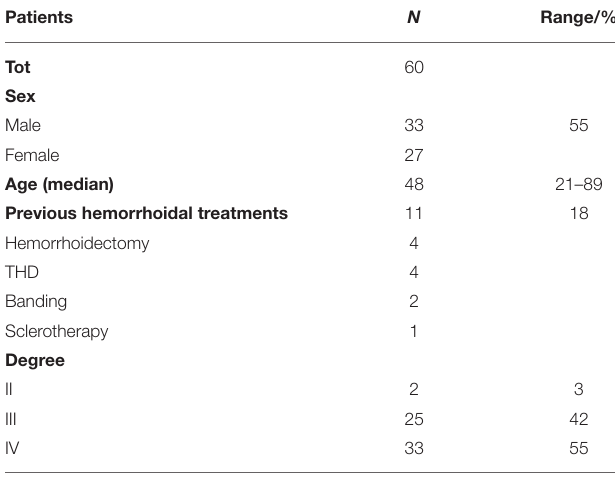
TABLE 1 | Patients’